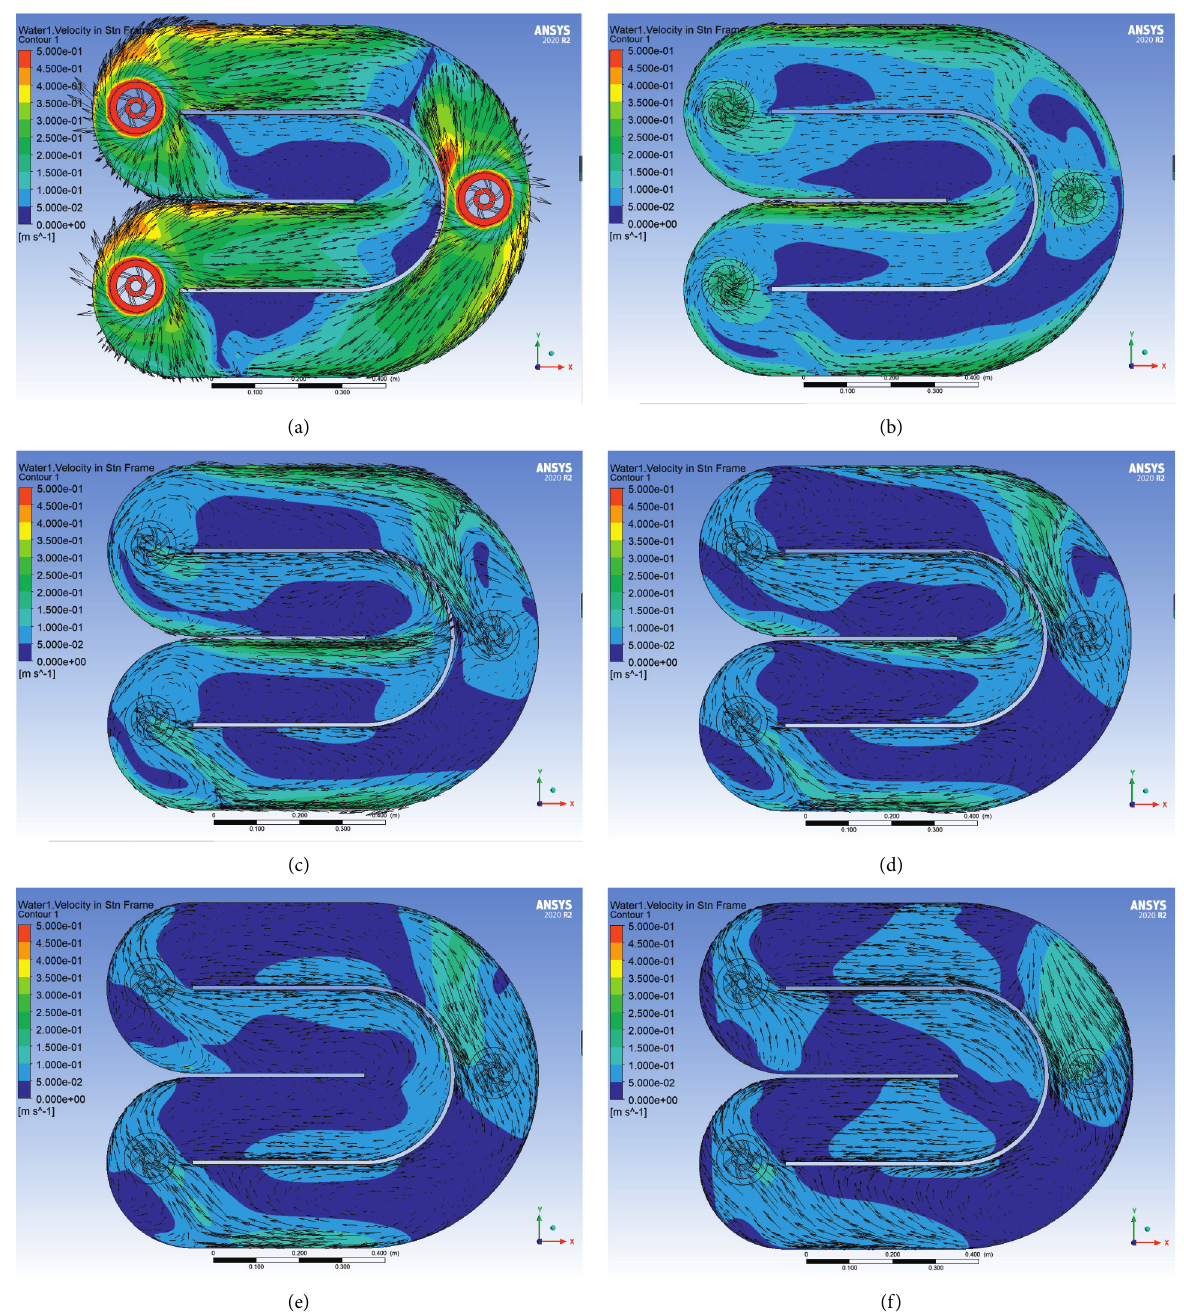
Figure 8: Vector and velocity cloud maps at different depths (a) H � 300mm, (b) H � 250mm, (c) H � 200mm, (d) H � 150mm, (e) H � 100mm, and (f) H � 50